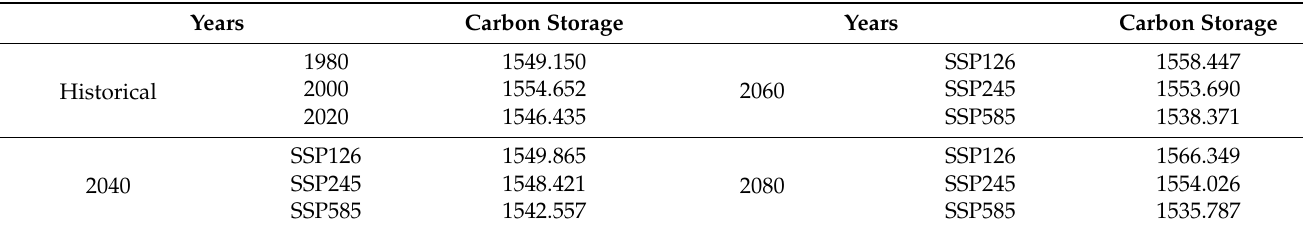
Table 2. Changes in forest carbon storage (unit: 10 6